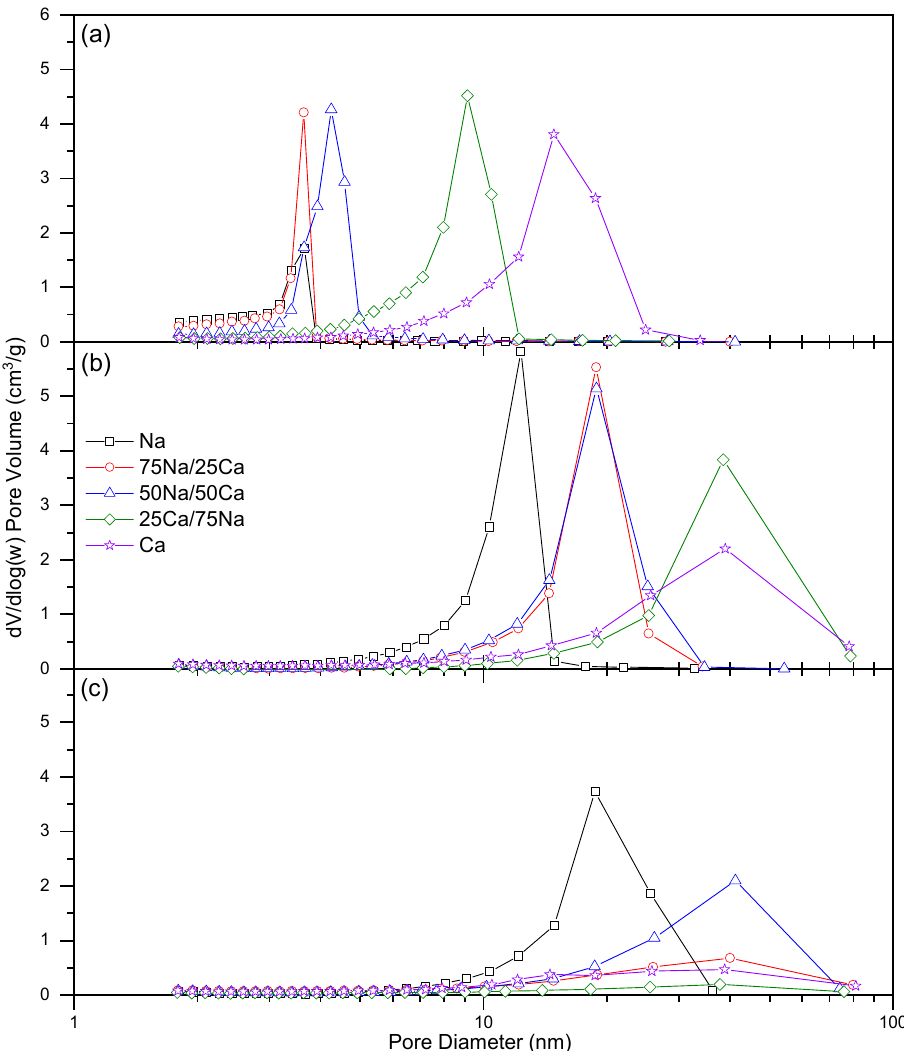
Figure 5. The pore size distributions obtained for the resorcinol–formaldehyde xerogels produced using 30% solids content and ( a ) R/C 100, ( b ) R/C 400, and ( c ) R/C 600.